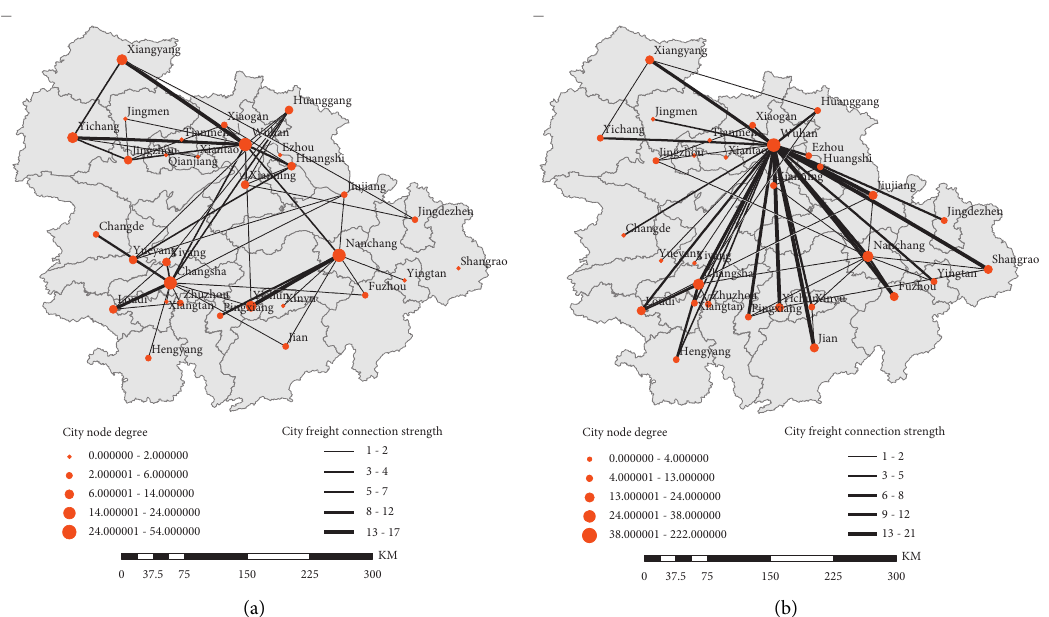
Figure 2: Characteristics of freight connection intensity of urban agglomerations in the middle reaches of the Yangtze river in 2014 (a) and 2018